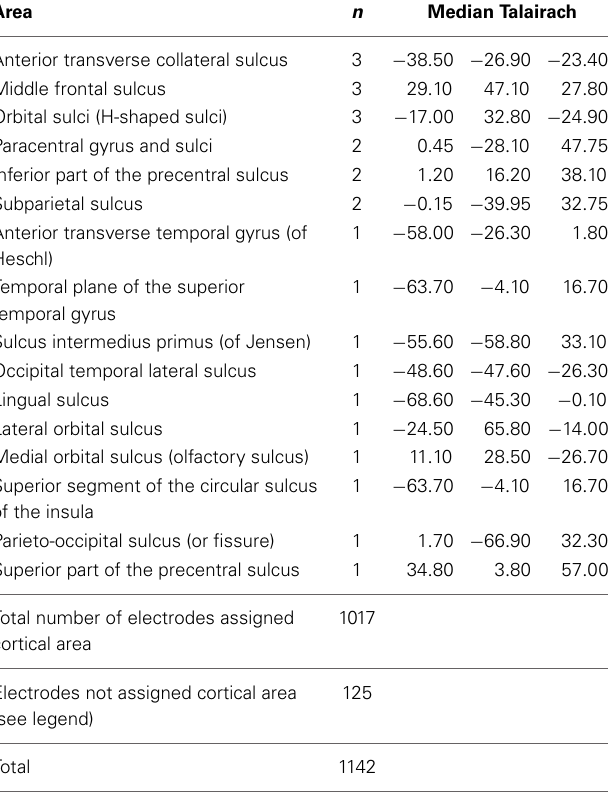
Table 1 | Location of all electrodes analyzed in this study ( N = 14 subjects) conveying the range of sampled